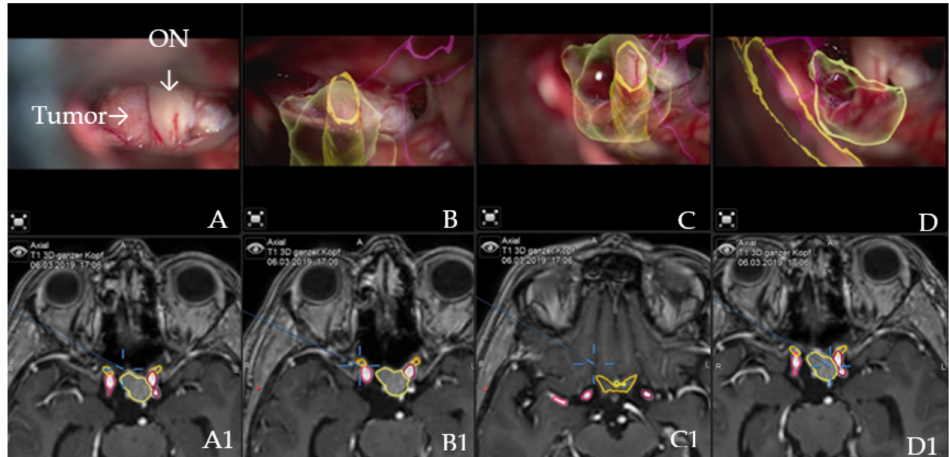
Figure 2. AR accuracy check. Patient no. 21 underwent a resection for suprasellar meningioma via right pterional approach. ( A ) Microscope video with focus on the tumor following exposure, with ( A1 ) T1-weighted post-contrast MRI axial view of standard navigation display with segmented objects (tumor, optic chiasm and nerves in yellow and carotid arteries in violet). Focus of the microscope is shown as seen on the standard navigation display. ( B ) Microscope video with head-up display and 3- dimensional (3D) visualization of the segmented objects during the resection, with focus on right optic nerve, which shows high accuracy with the intraoperative situation. ( B1 ) T1-weighted post-contrast MRI axial view of navigation, with focus on right optic nerve. ( C ) Microscope video with head-up display and 3D visualization of tumor outline, optic nerve and ipsilateral carotid artery following tumor resection with focus on the skull base with ( C1 ) T1-weighted post-contrast MRI axial view of navigation. ( D ) Same as in C, microscope focus is on the contralateral carotid artery; segmented tumor outline and the course of the contralateral optic nerve are visualized with ( D1 ) T1-weighted post-contrast MRI axial view of navigation, which shows focus of the microscope as seen on the standard navigation